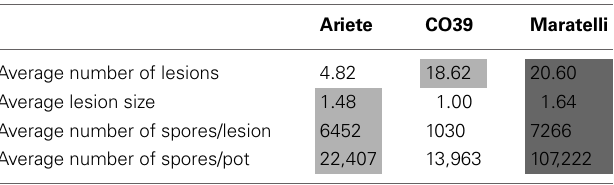
Table 1 | Average performance of the three varieties on the three traits we measured.